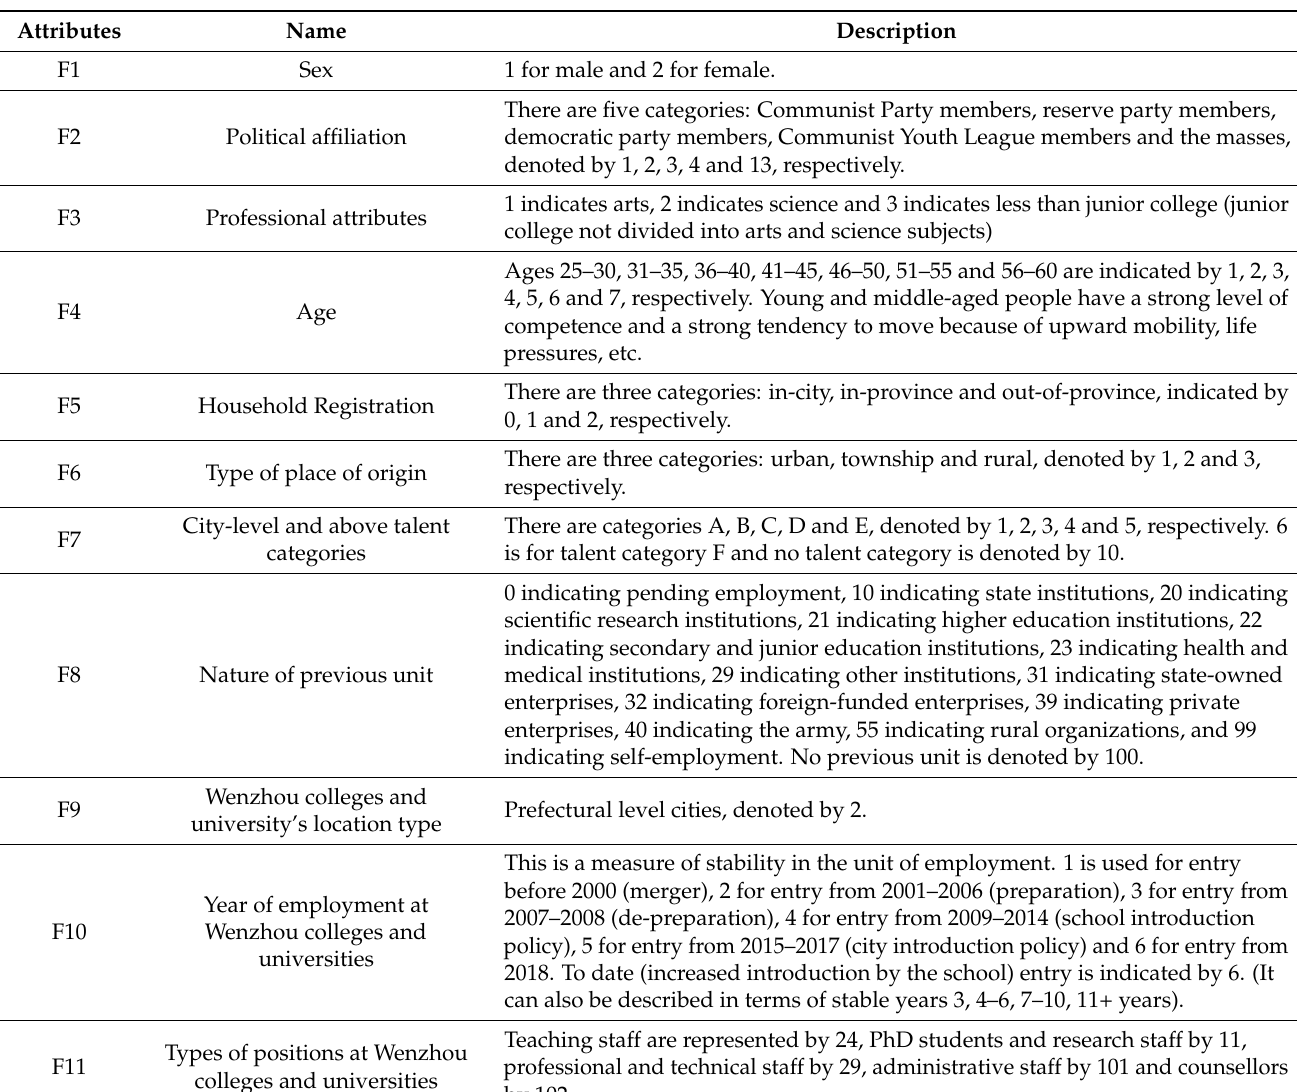
Table A6. Description of each attribute for the talent stability